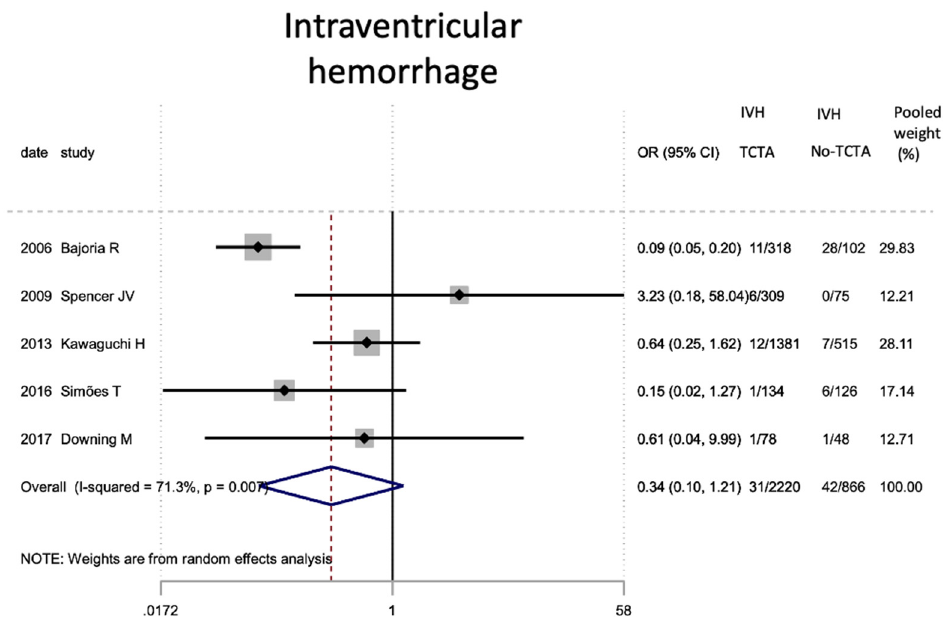
Figure 13. Results of the meta-analysis on the effect of chorionicity (TCTA vs no TCTA) on the development of severe stage III-IV intraventricular hemorrhage. IVH: intraventricular hemorrhage; TCTA: trichorial-triamniotic, non-TCTA: non-trichorial-triamniotic. OR = odds ratio, CI = confidence interval.